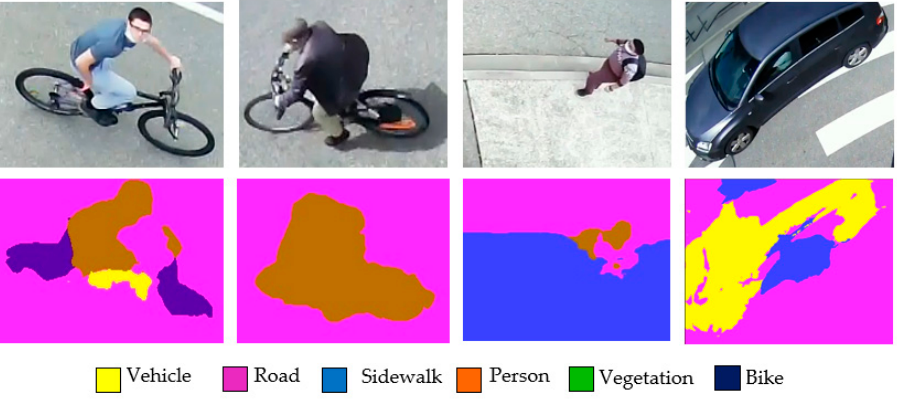
Figure 6. Typical cases of poor segmentation of road users with FC-HarDNet. One can observe that the model occasionally struggles to detect road users of any type. The primary defects found were: